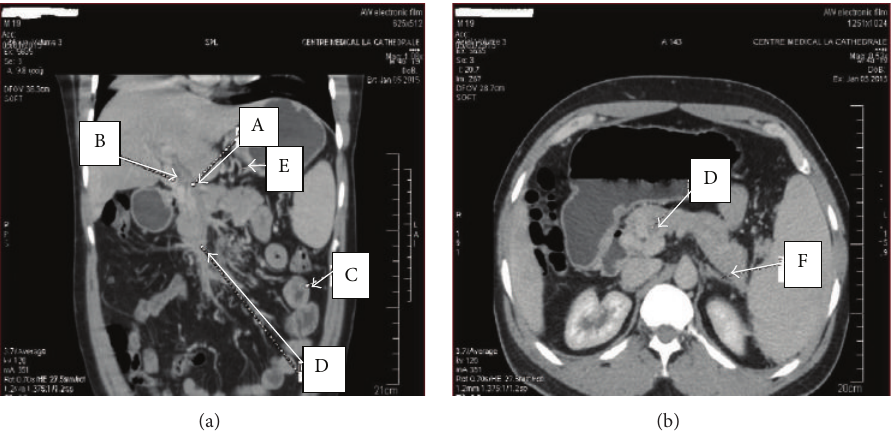
Figure 3: Abdominal contrast-enhanced CT scanner: control after three months on oral anticoagulation. (a) Partial recanalization of the portal venous thrombosis (A) and the superior mesenteric venous thrombosis (D), the portal cavernoma (B) and gastric collateral vessels (E), and thickening of the small intestinal bowel (C). (b) Superior mesenteric venous partial recanalization (D) and residual inflammatory flows (F). Light Speed CT-16 (GE Medical Systems, USA), contrast: iobitridol 300 mg/mL (Xenetix, Guerbet, Roissy CDG Cedex, France). With the permission of the Cathedral Medical Center (CMC),